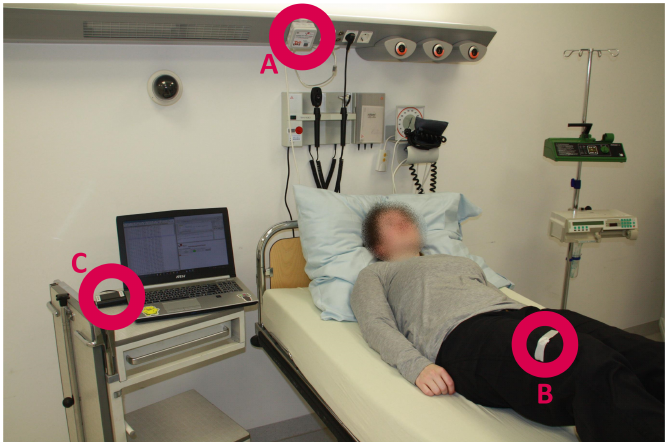
Figure 5. Structure of the INBED system (A: relay node, B: wearable, C: base